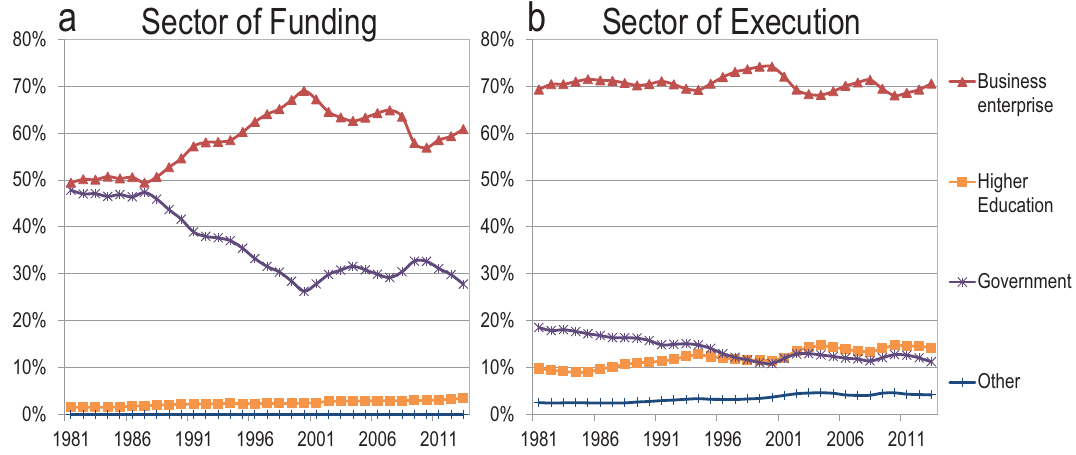
Fig 4. Proportion of (A) funding and (B) execution of R&D activities, by sector, United States, 1981–2013 (OECD